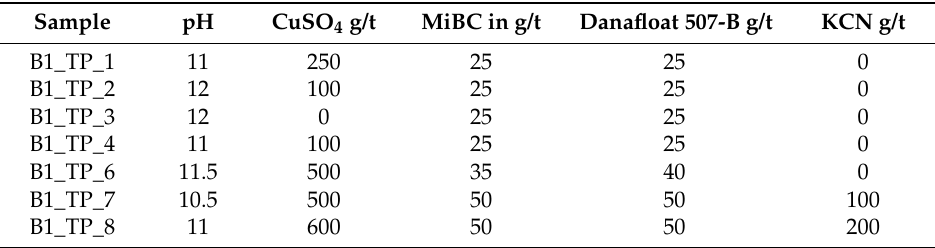
Table 2. Parameters for preliminary flotation